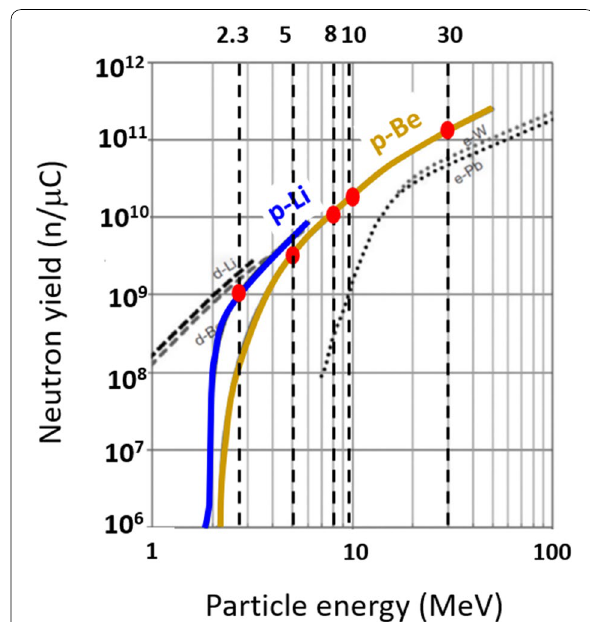
Fig. 3 Neutron yields from various nuclear